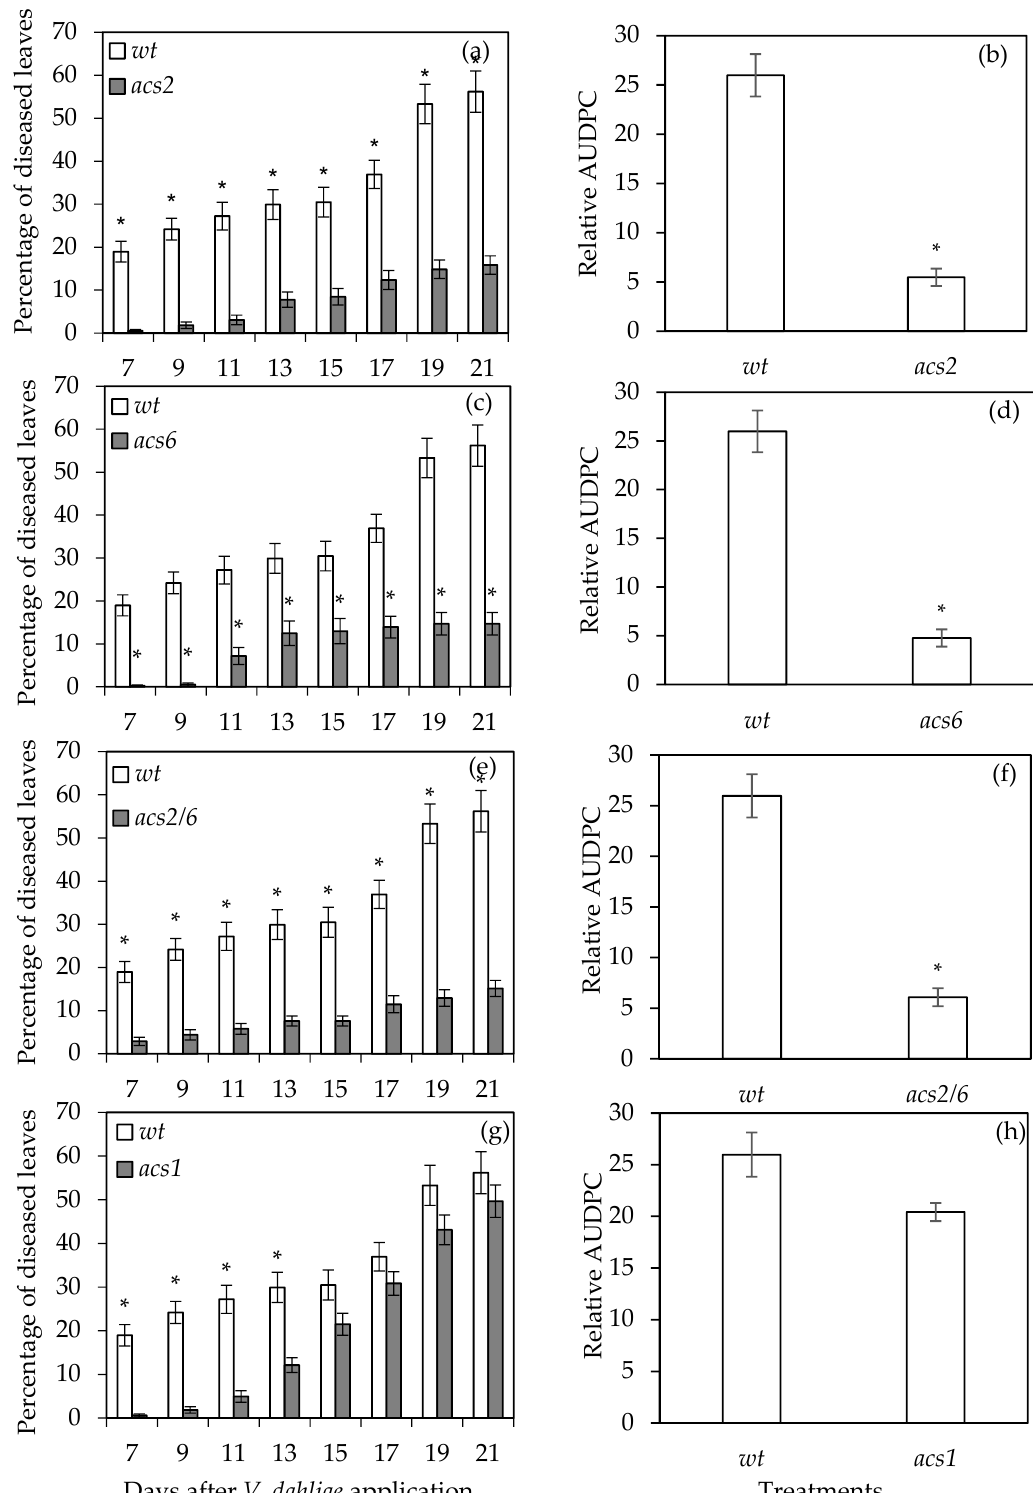
Figure 1. Disease severity ( a , c , e , g ) and relative area under the disease progress curve (AUDPC) ( b , d , f , h ) on Arabidopsis thaliana wild type and 1-aminocyclopropane-1-carboxylic acid synthase ( acs)2 , acs6 , acs2 / 6 , and acs1 mutants inoculated with Verticillium dahliae . Each treatment consisted of 10 plants and the experiment was repeated three times. Columns represent means of the three replications (30 plants) and the vertical bars indicate standard errors. Columns with asterisks (*) are significantly different ( p < 0.05) from wild type (wt) according to a t -test.